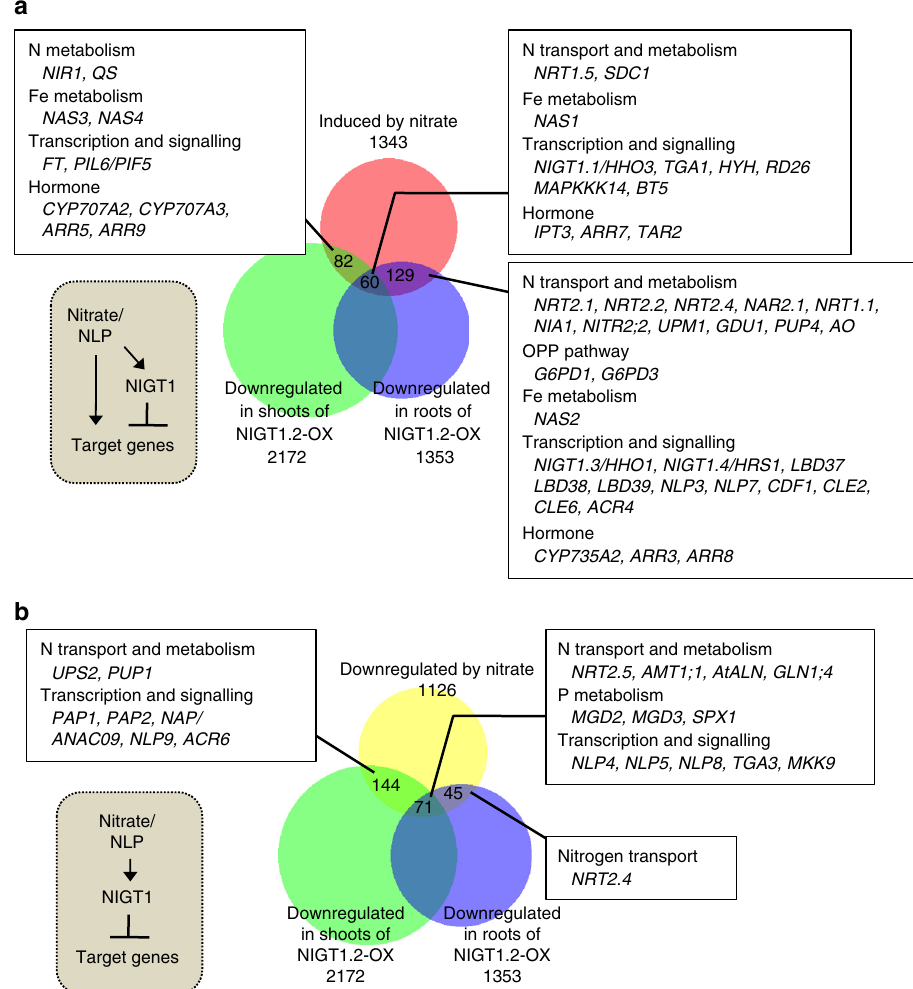
Fig. 3 Nitrate-responsive and NIGT1-regulated genes. a A Venn diagrams showing an overlap between genes upregulated by nitrate after 30 min or 3 h and genes downregulated in NIGT1.2-overexpressing plants. b A Venn diagram showing an overlap between genes downregulated by nitrate after 30 min or 3 h and downregulated in NIGT1.2-overexpressing plants. Numbers of genes are shown. Note that NRT2 . 4 was upregulated at 30 min after nitrate treatment but downregulated at 3